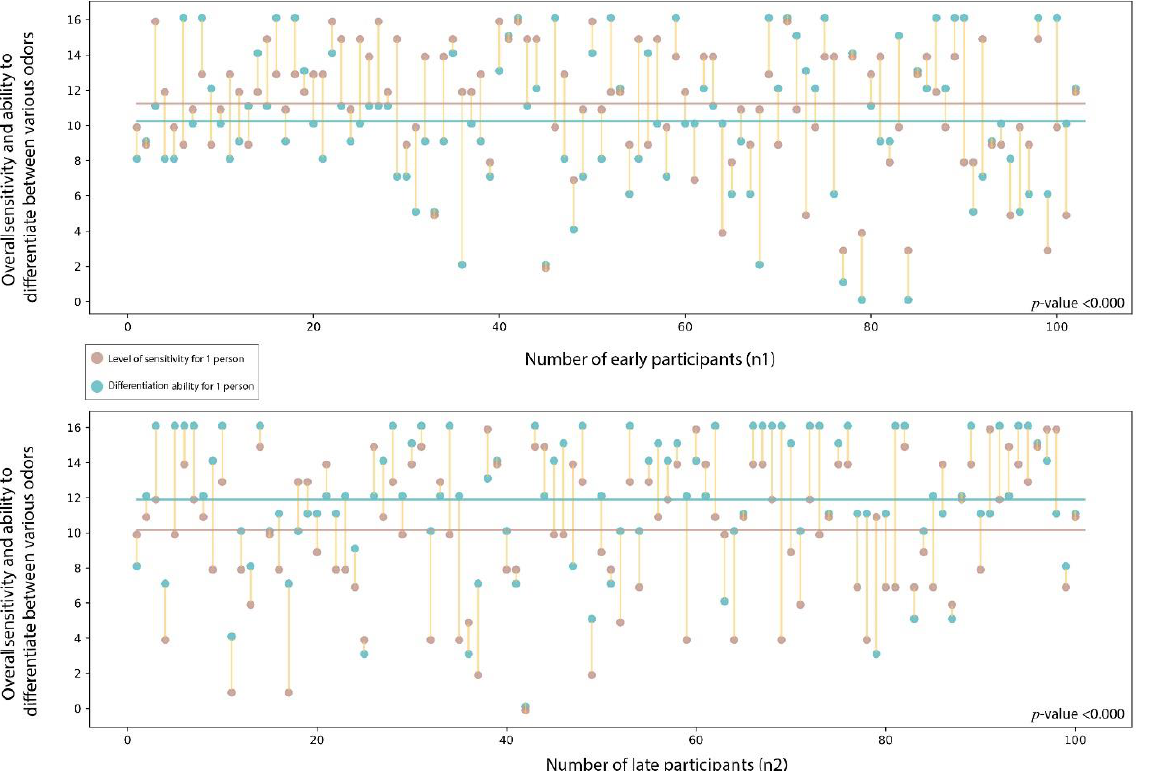
Figure 5. The differences in the overall sensitivity of smell and ability to differentiate between various odors as cumulatively stimulated by both the olfactory and trigeminal nerves among participants of the early and late groups.